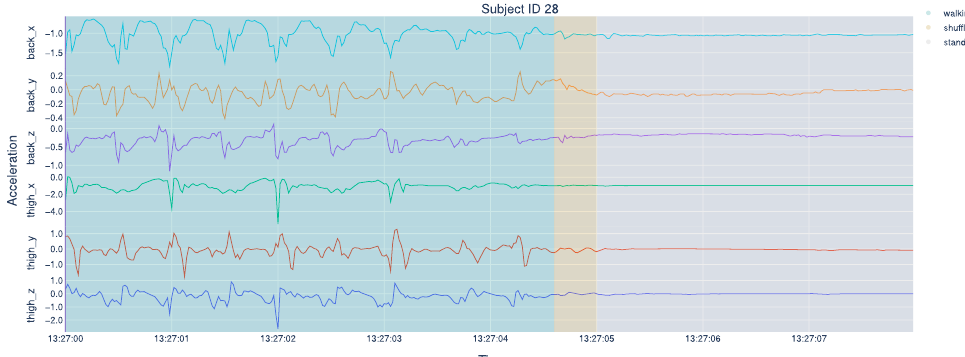
Figure 3. This figure shows ten seconds (x-axis) of the acceleration signals (on the y-axis and in m/s 2 ) of all three axes of the back and thigh accelerometers. We focus on the subject with subject ID 28. The background is shaded according to the activity label, in this case walking (green), shuffling (yellow), and standing